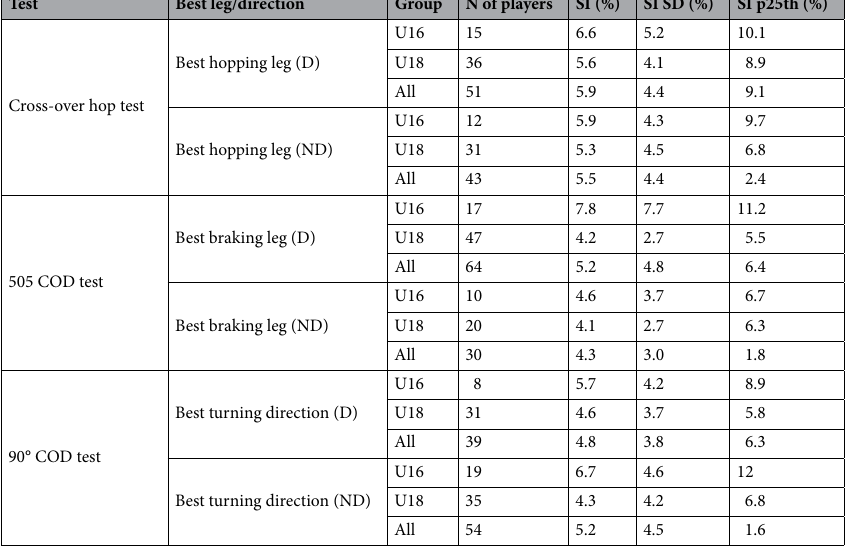
Table 1. Descriptive values of the symmetry index by COD test and by best hopping leg (cross-over hop test), best braking leg during cutting (505 COD test) or best turning direction (90° COD test). D dominant, ND non-